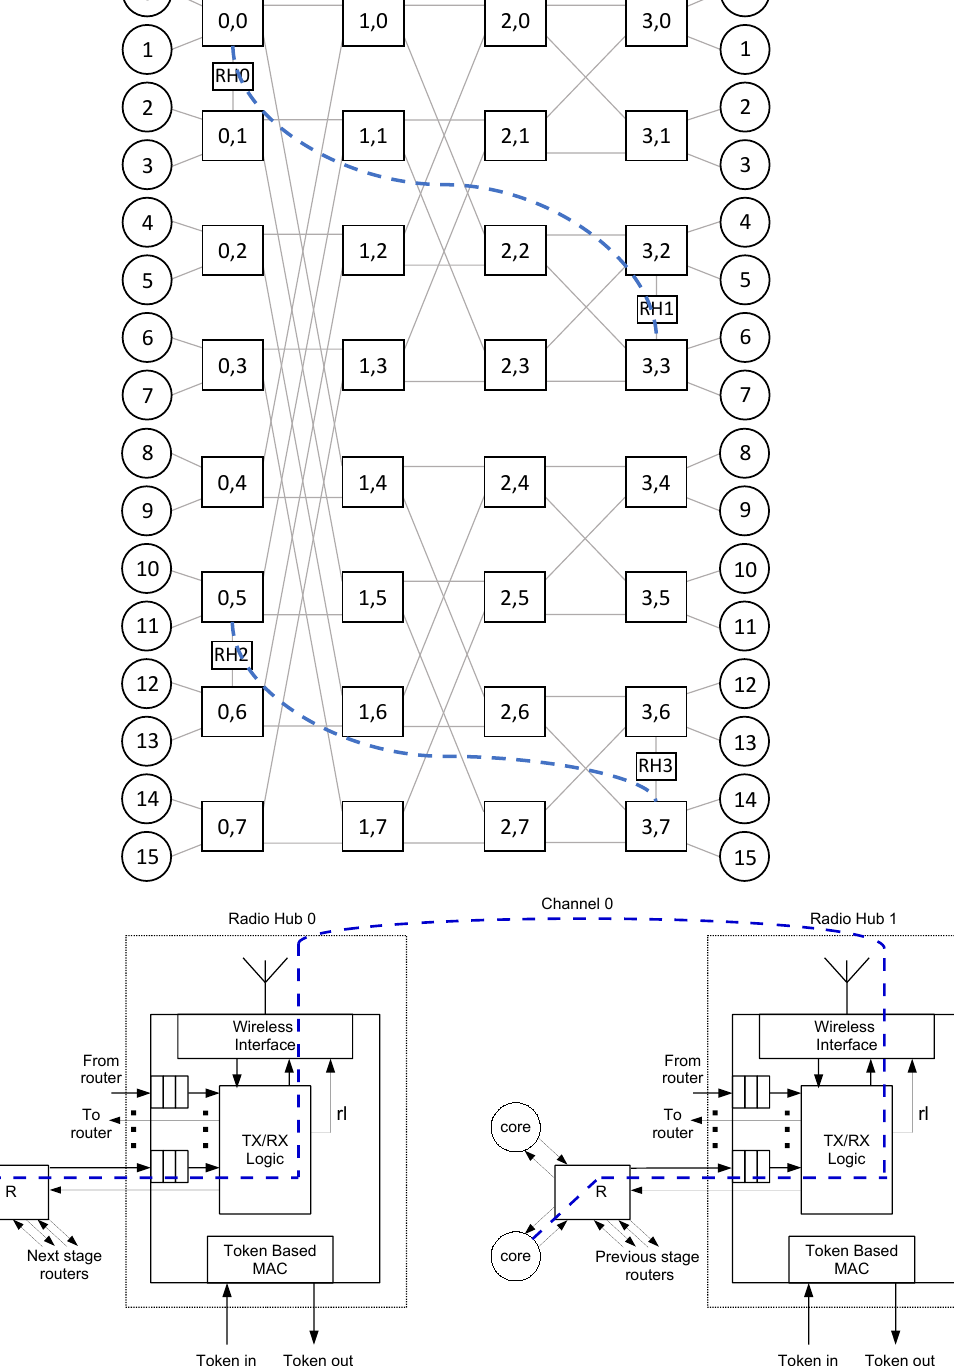
Figure 3. Delta MIN with 16 cores augmented with 4 radio-hubs. Detail of the end-to-end communication by means of two radio-hubs sharing a wireless channel connected to switches in the first and last